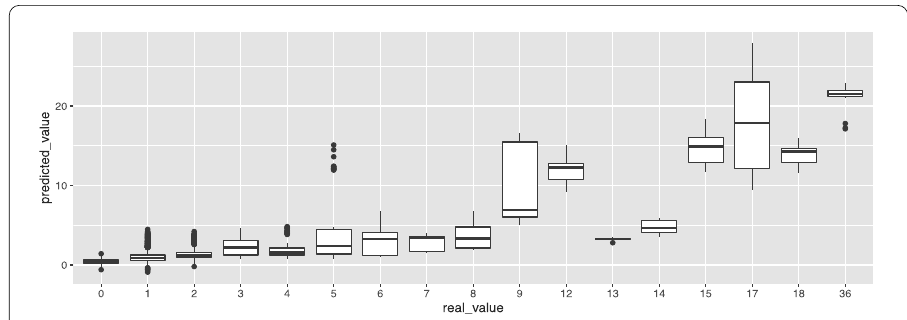
Figure 8 Boxplot of the predicted values for real values